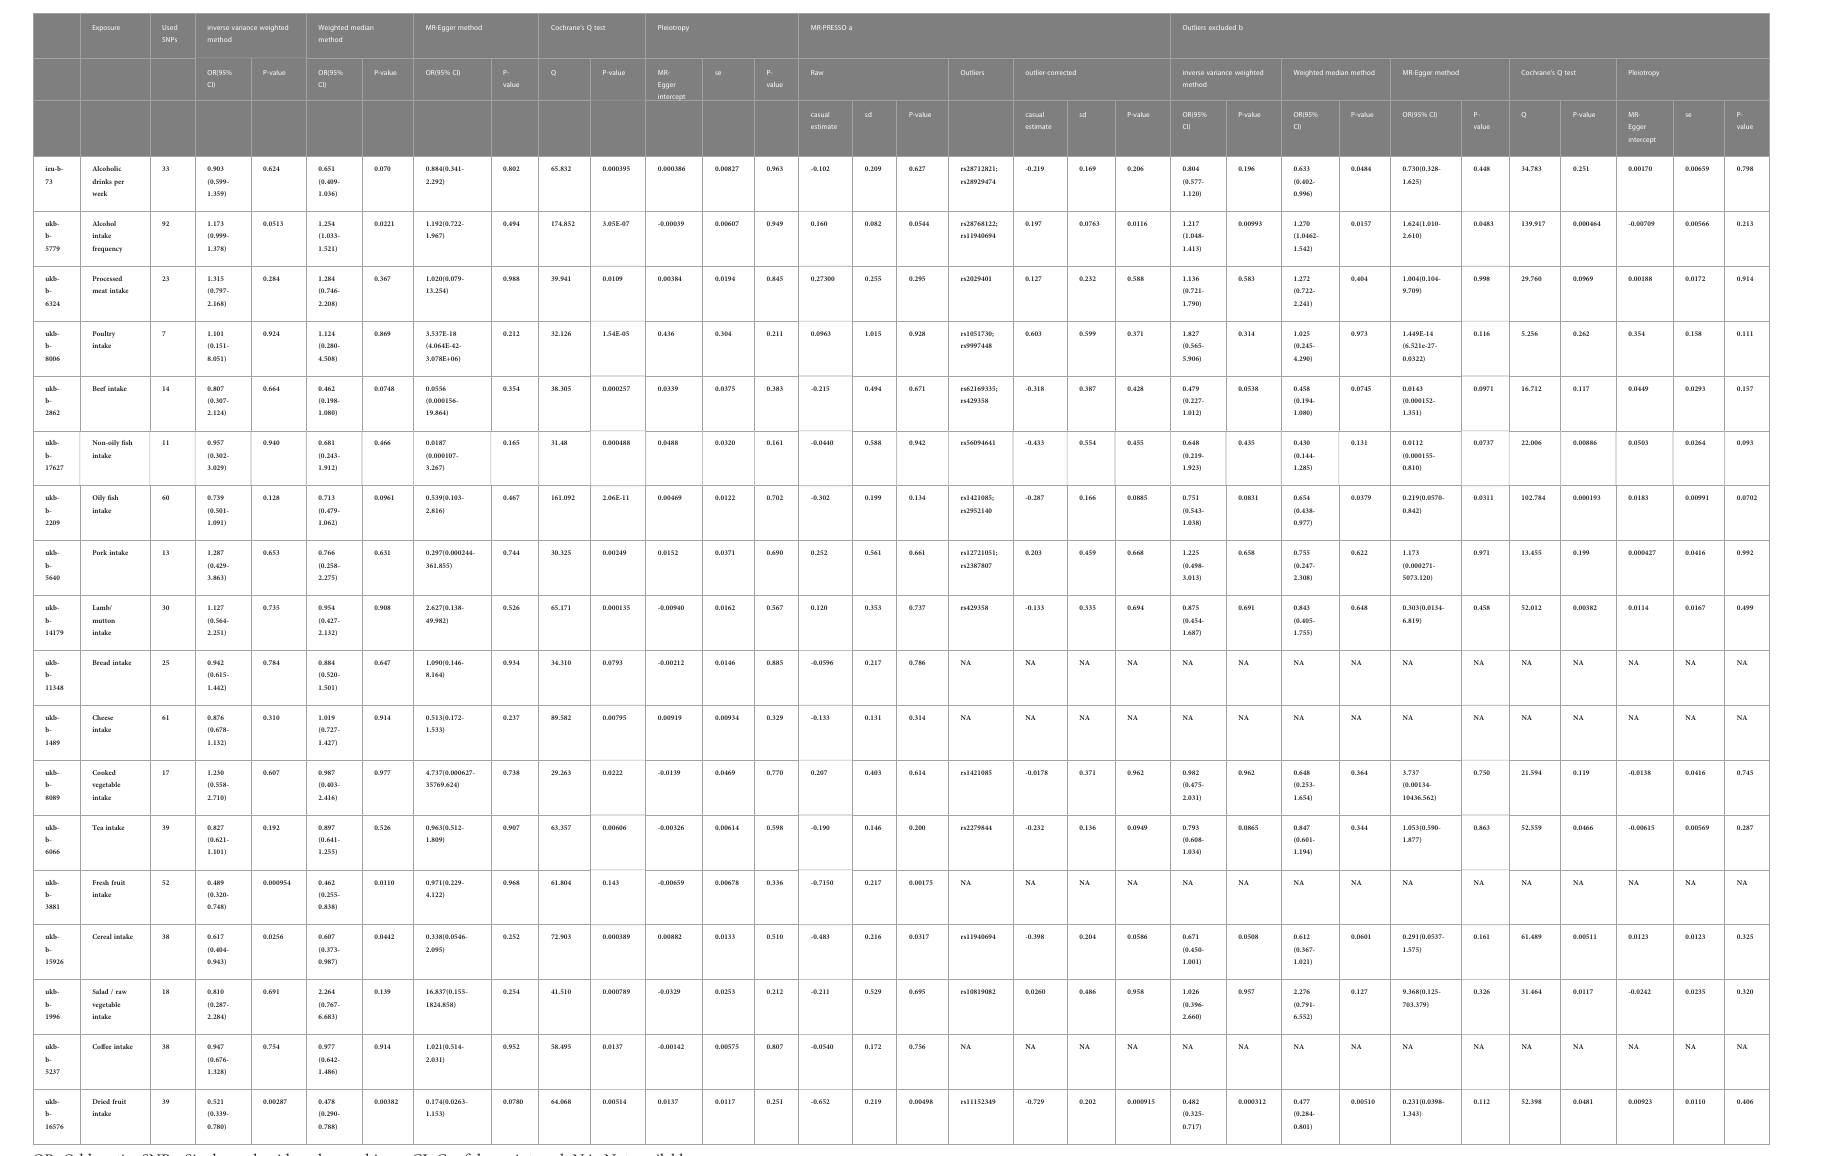
TABLE 2 The results of Mendelian randomization